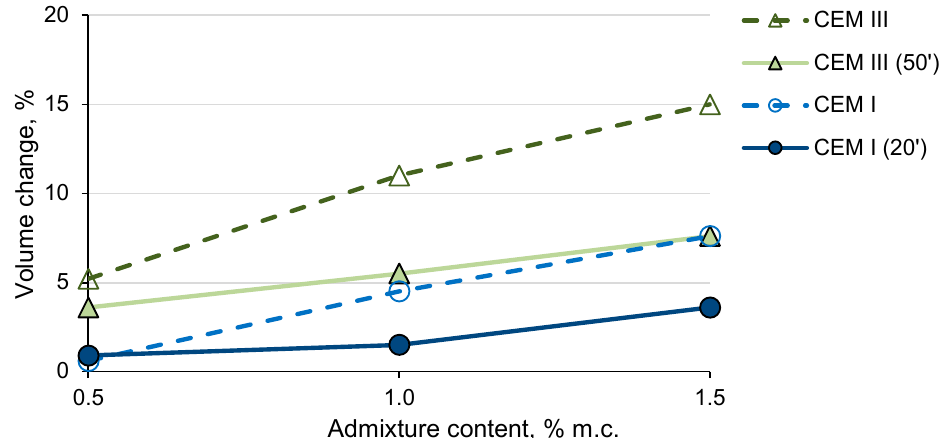
Figure 9. Change of mortar volume with the admixture in relation to the mortar without admixture formed after mixing components of mortar (CEM I and CEM III) and formed after air content test (CEM I (20 ′ ) and CEM III (50 ′ )).